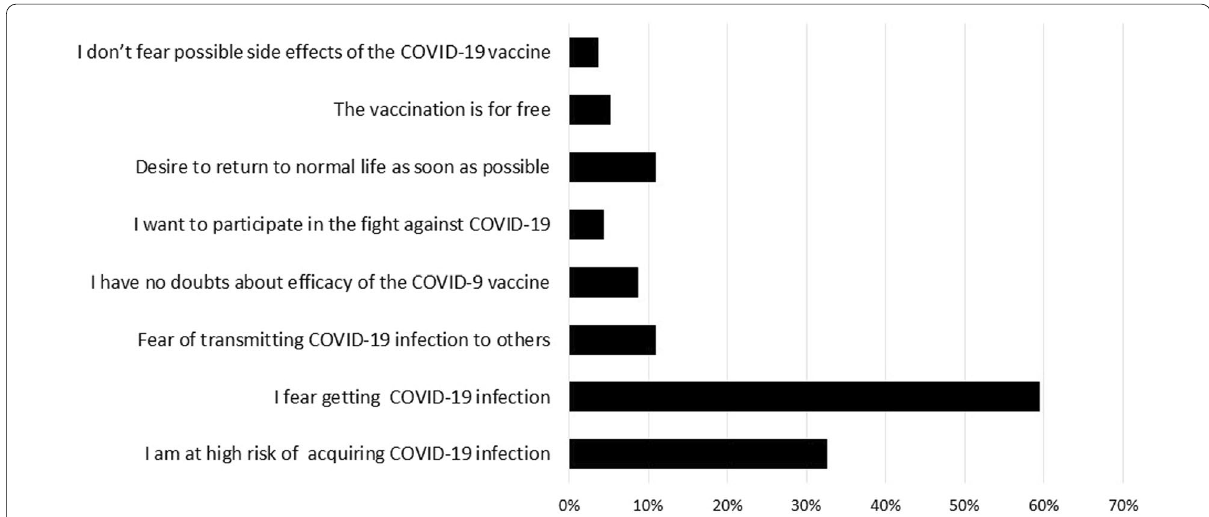
Fig. 2 The motivators for COVID ‐ 19 vaccination among the vaccine acceptant group of hemodialysis patients [ n